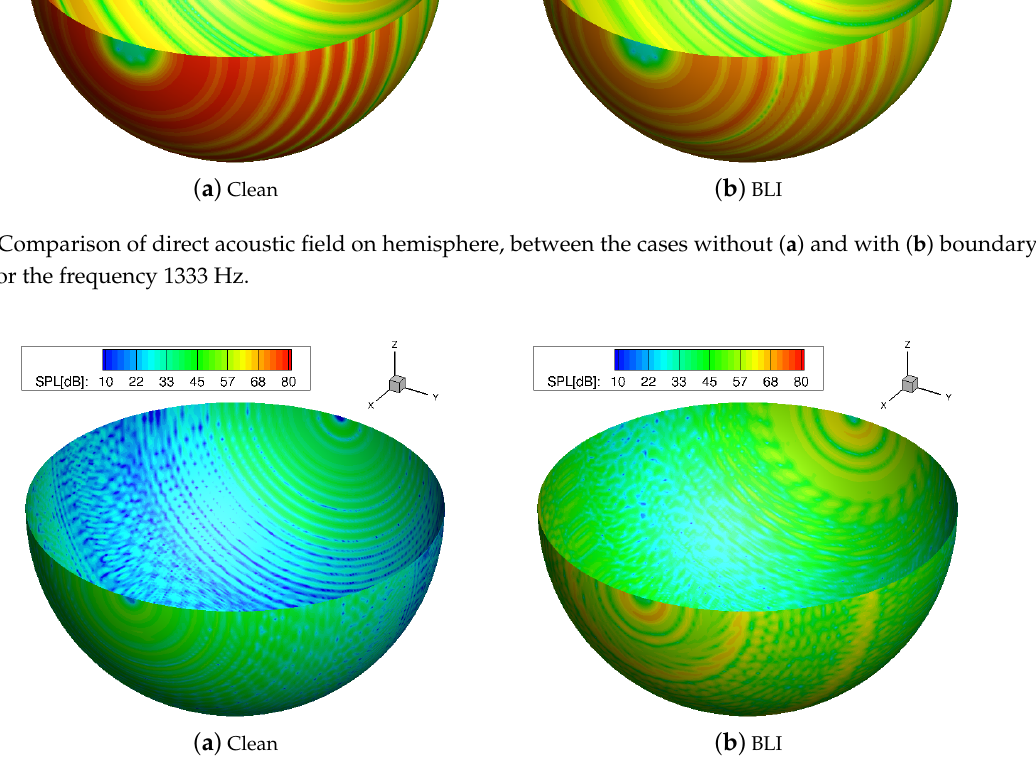
Figure 13. Comparison of direct acoustic field on hemisphere, between the cases without ( a ) and with ( b ) boundary layer ingestion for the frequency 3333